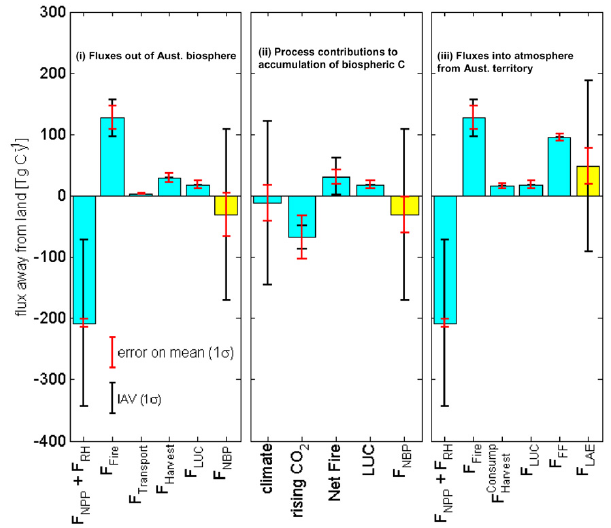
Fig. 2. (i) Net flux of carbon out of the Australian biosphere ( F NBP , yellow) as the sum of components (blue); (ii) net flux of carbon out of the Australian biosphere ( F NBP , yellow) as the sum of process contributions (blue) due to variable climate, rising CO 2 , net effect of fire (mainly clearing fires) and LUC; (iii) net flux of carbon from the Australian territory to the atmosphere ( F LAE , yellow), as the sum of components (blue). Error bars represent errors on the mean (1 σ , red) and interannual variability (1 σ ,